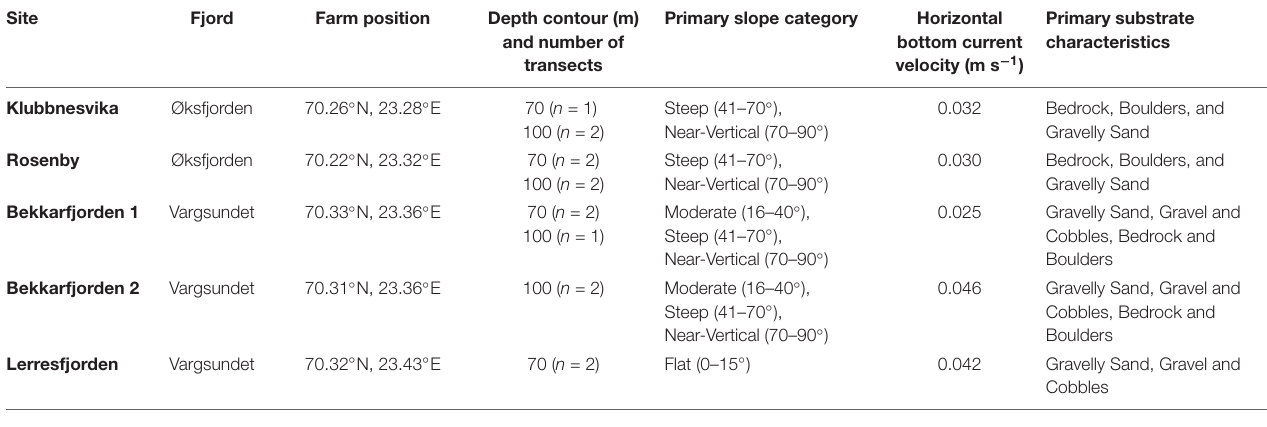
TABLE 1 | Survey site locations and characteristics.